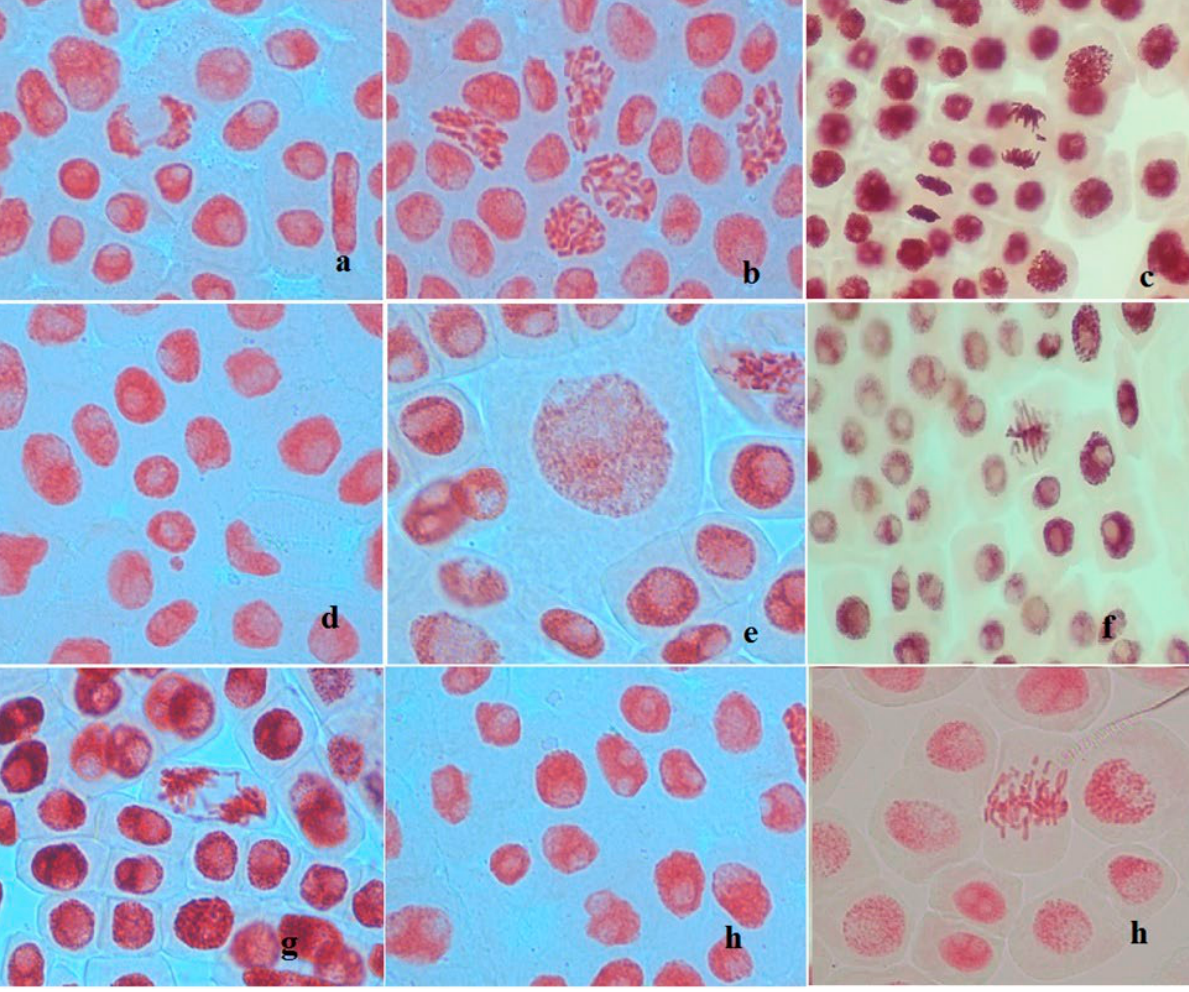
highest metaphases percentage was determined in L 10% 24h and L 10% 48h variants. The calculated percentage values for anaphase and telophase were not significantly different compared to the control.